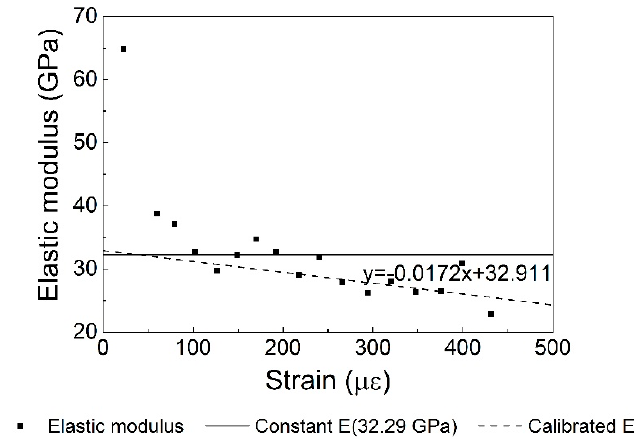
Figure 5. Calibrated elastic modulus of TP